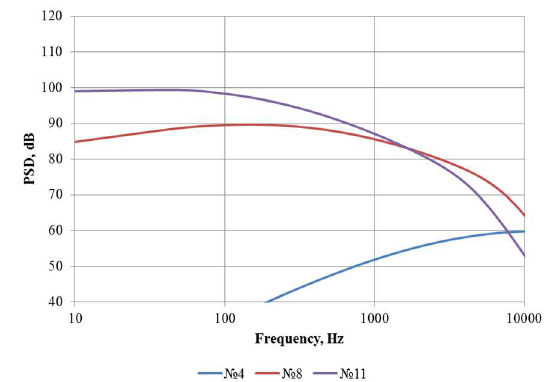
Fig. 14. PSD of the wall-pressure based on the proposed model.